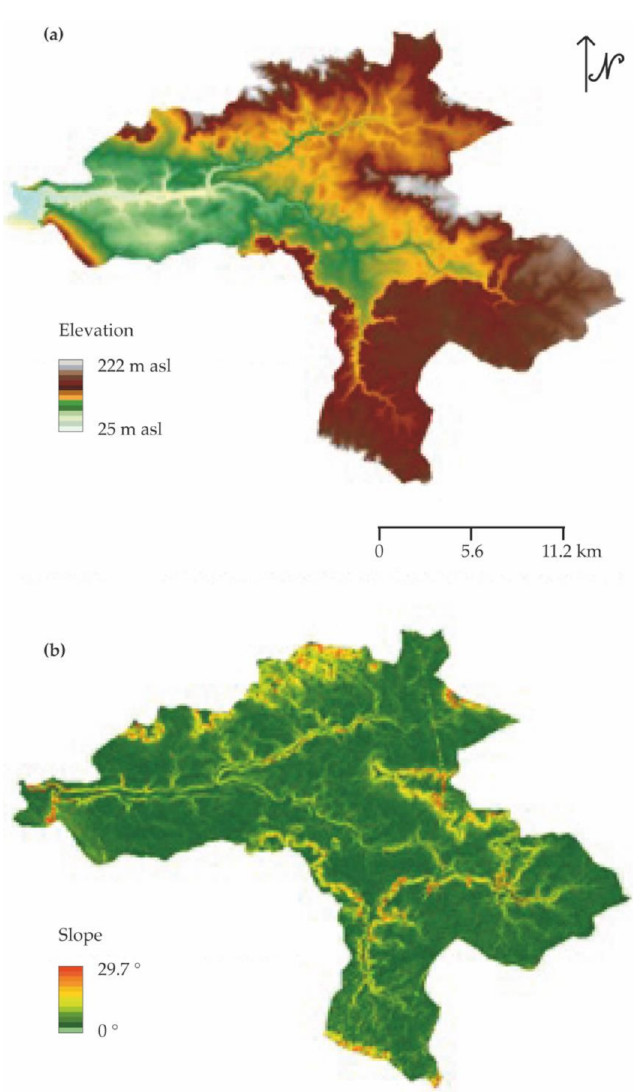
Figure 4. ( a ) Digital elevation model of Nonette catchment; ( b ) slope raster of Nonette